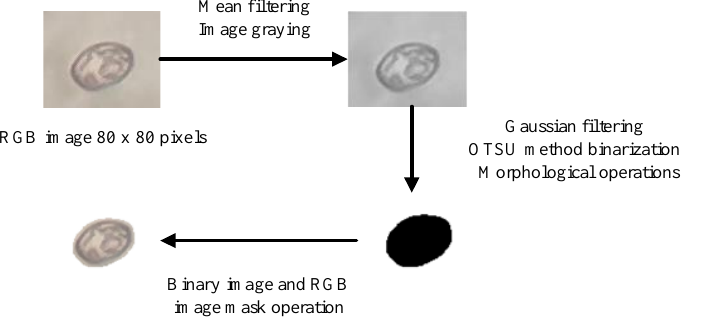
Figure 3. Spore image pre-processing.